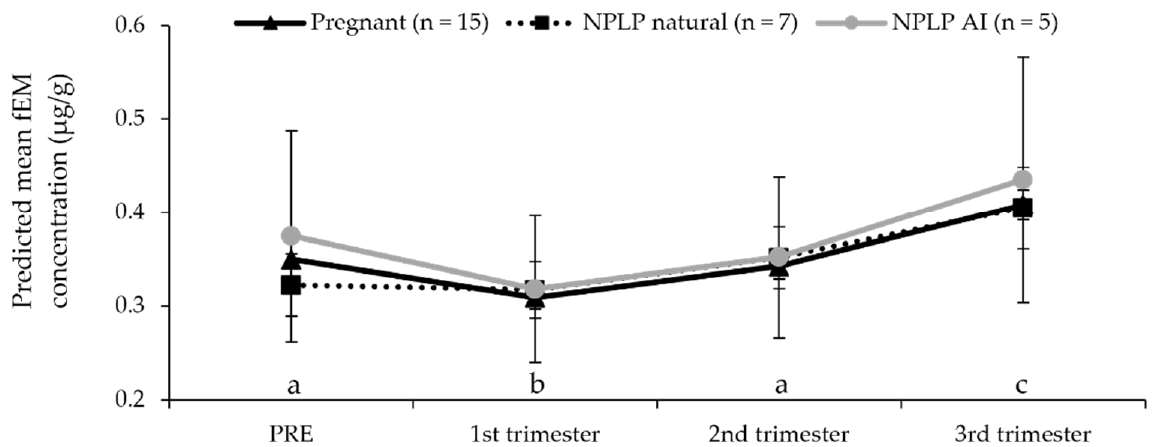
Figure 2. Time period predicted mean concentrations for fecal estrogen metabolites (fEM) from female cheetahs experiencing ovulatory events: pregnant, confirmed by birth of cubs, or a non-pregnant luteal phase (NPLP) following natural breeding or exogenous hormone stimulation and artificial insemination (AI), but no cubs resulted. Different lower-case letters denote differences ( p < 0.05) among time periods for all ovulatory events.